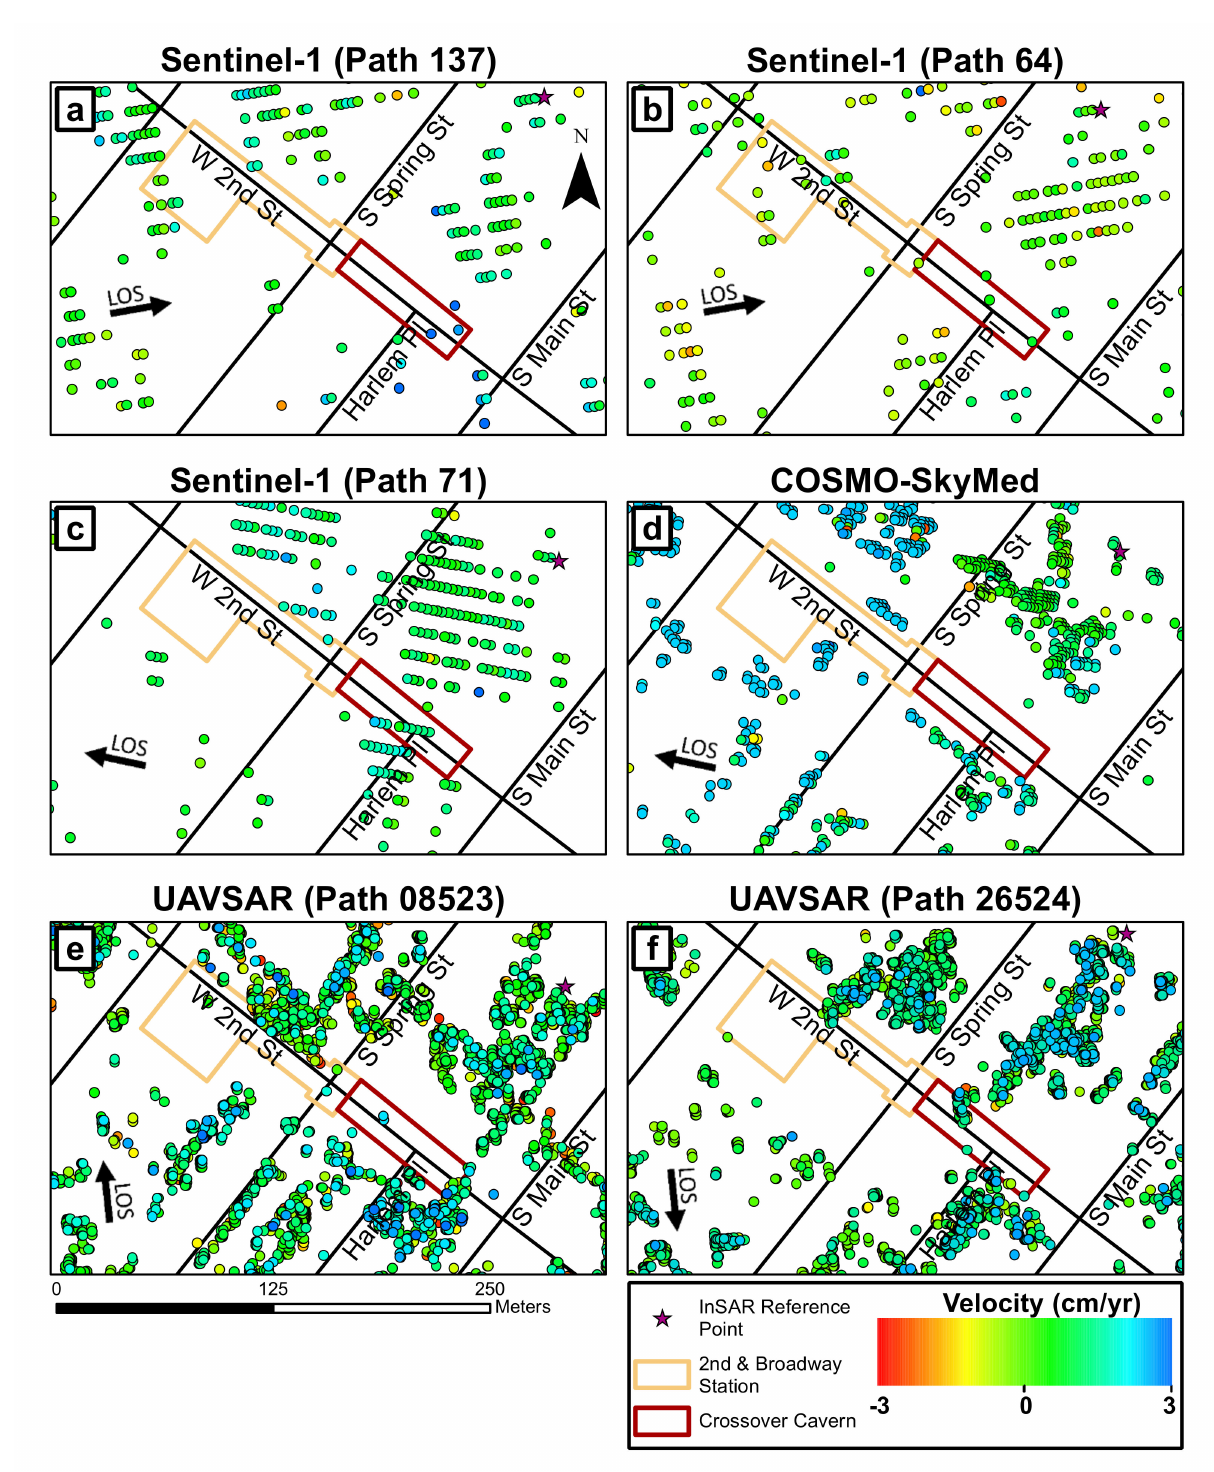
Figure 4. ( a – f ) Persistent scatterer pixel locations and LOS velocities, reference pixel locations, and LOS azimuth vectors associated with spaceborne and airborne InSAR datasets. LOS velocities shown are averaged over the time period between 16 November 2018 and 21 February 2019. Negative LOS velocities, shown in warmer colors, indicate motion toward the SAR sensor. Positive LOS velocities, shown in cooler colors, indicate motion away from the SAR